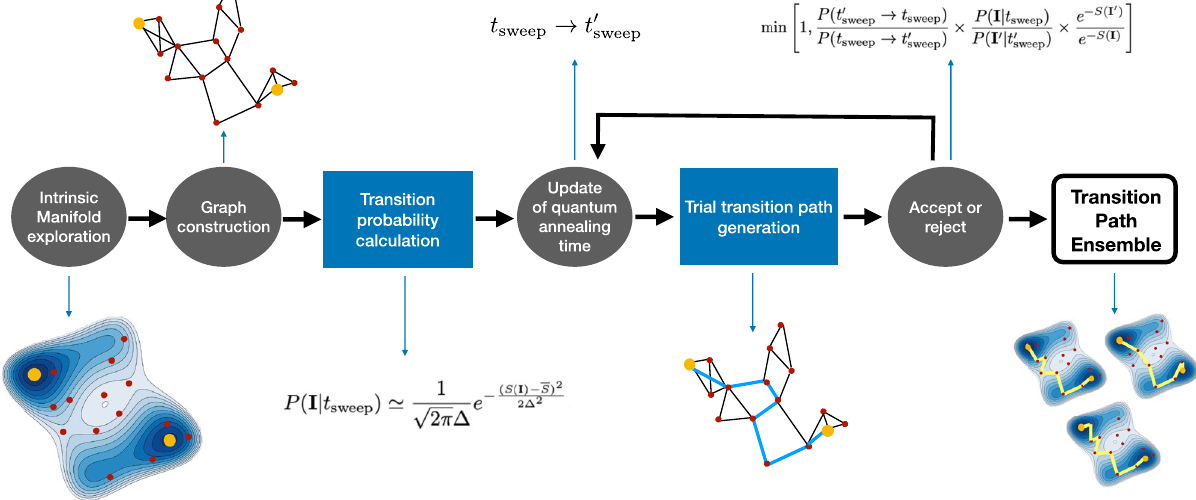
Figure 1. Schematic representation of the path sampling scheme introduced in this work, which combines ML and MD performed on a classical computer with QC performed on a quantum annealing machine. Our scheme samples the full transition path ensemble without any use of CVs or unphysical